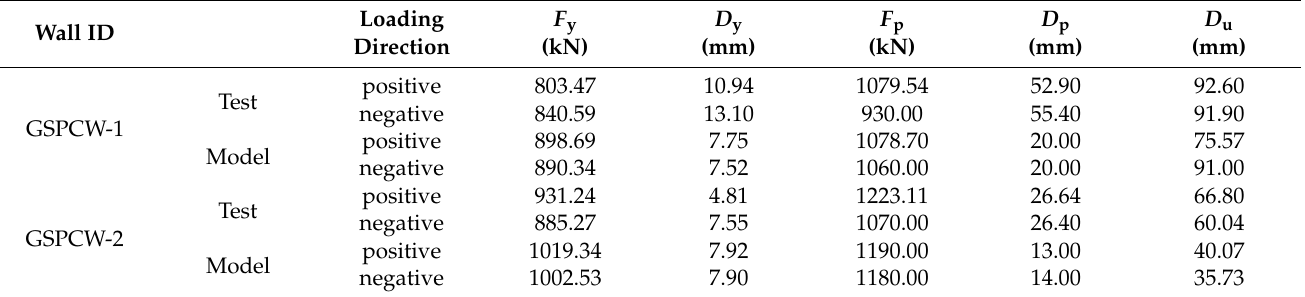
Table 2. Comparison of characteristic points of skeleton